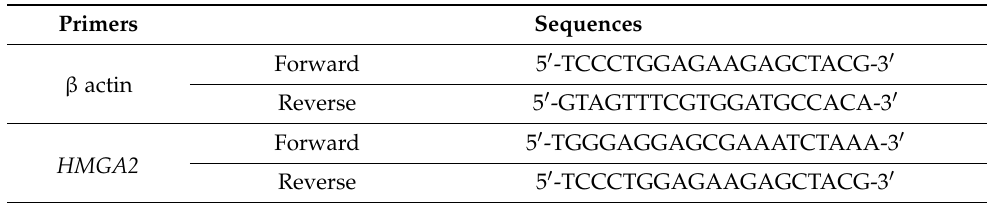
Table 1. Sequences of the oligonucleotide primers used for PCR amplification.